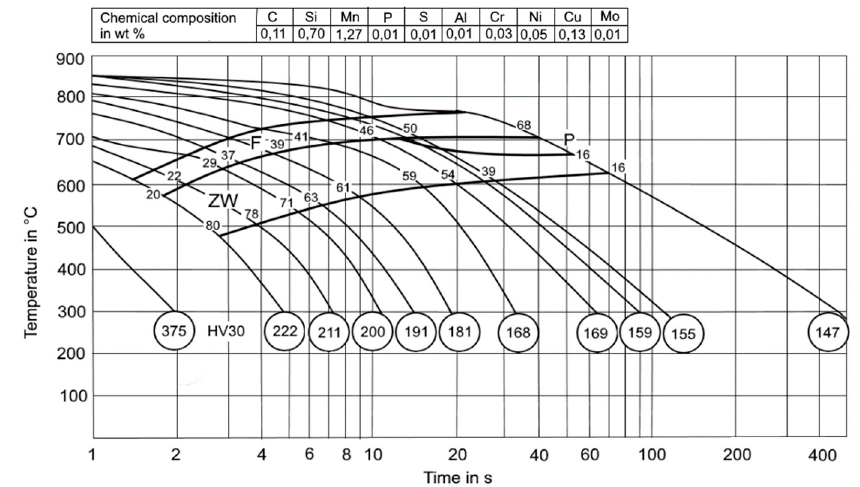
Figure 10. Welding time-temperature-transformation (TTT) diagram for G4Si1 and peak temperatures of 1350 °C, according to [41].